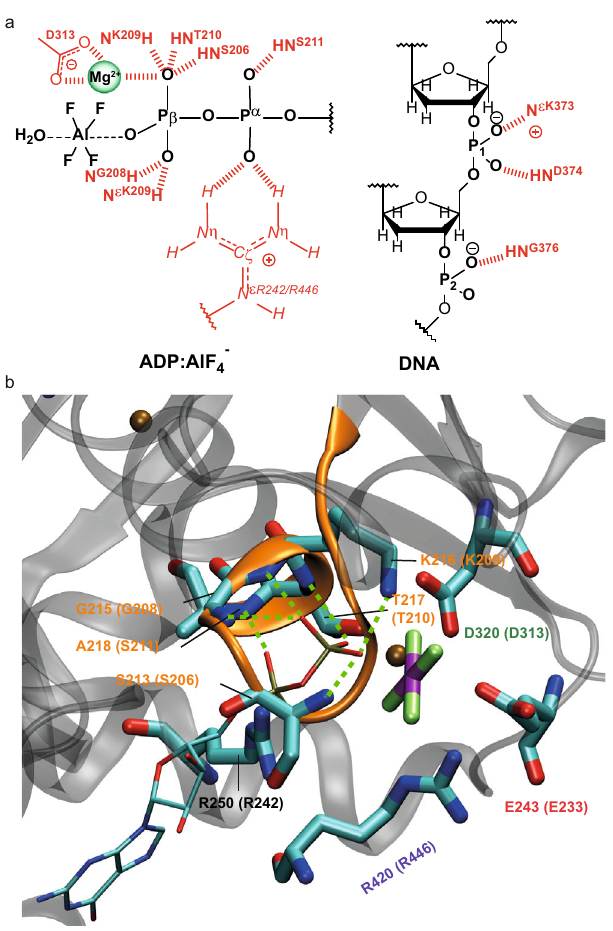
Fig. 7 Comprehensive model for molecular recognition events involved in ADP and DNA binding to DnaB as obtained from the herein presented EPR/NMR results. a Sketch of hydrogen-bond formation and spatial proximities as revealed by the hPH and chemical-shift temperature- dependence experiments for ADP and DNA coordination to Hp DnaB. The Mg 2 + co-factor has been placed in spatial proximity to the AlF 4 − unit supported by the results from the EDNMR spectra (the coordinating aspartate located in the Walker B motif is shown additionally 113 ). b Zoom into the nucleotide-binding domain for Bst DnaB:GDP:AlF 4 − :DNA (PDB accession code 4ESV). Residues given in brackets correspond to those in Hp DnaB. Green lines represent hydrogen bonds or spatial proximities as identi fi ed from the hPH correlation experiments.